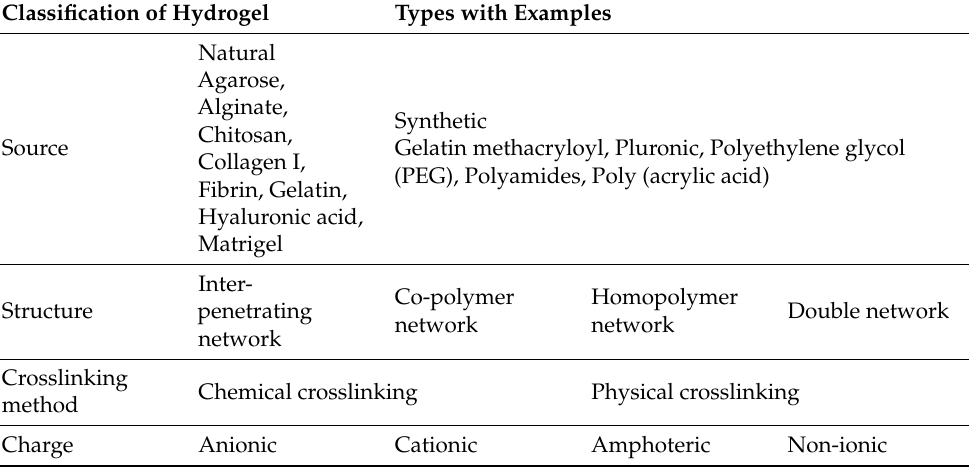
Table 1. Classification of hydrogels on the basis of source, structure, crosslinking, charge and bio- degradation.